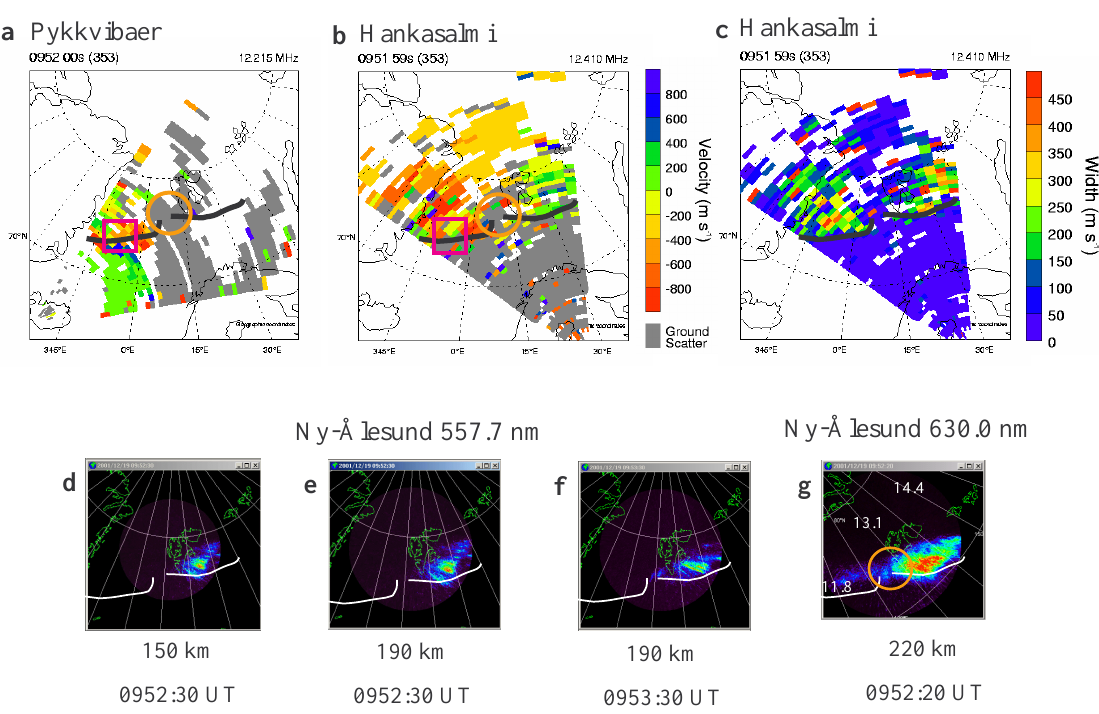
Fig. 10. Comparison of SuperDARN and optical data for the 2-min interval starting at 09:52 UT showing the line-of-sight velocities